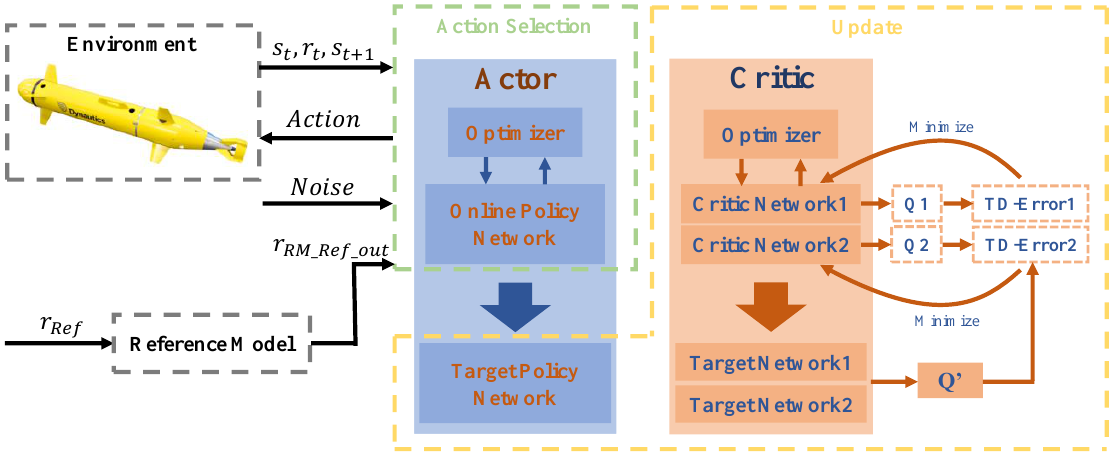
Figure 5. MR-TD3 controller structure; this framework is built in DRL